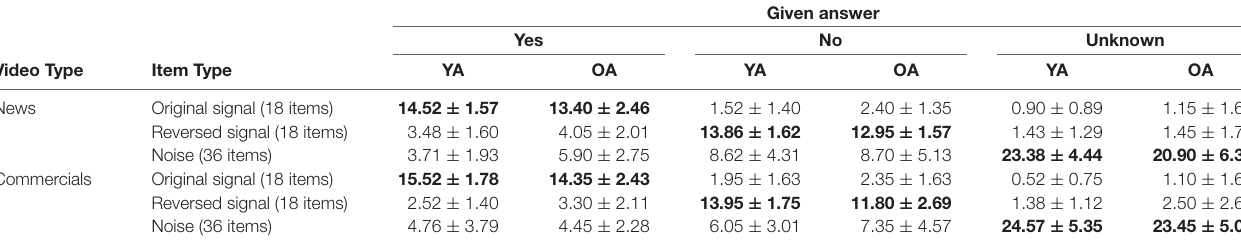
TABLE 3 | Means and Standard Deviations (M ± SD) for the number of responses given to each type of item.